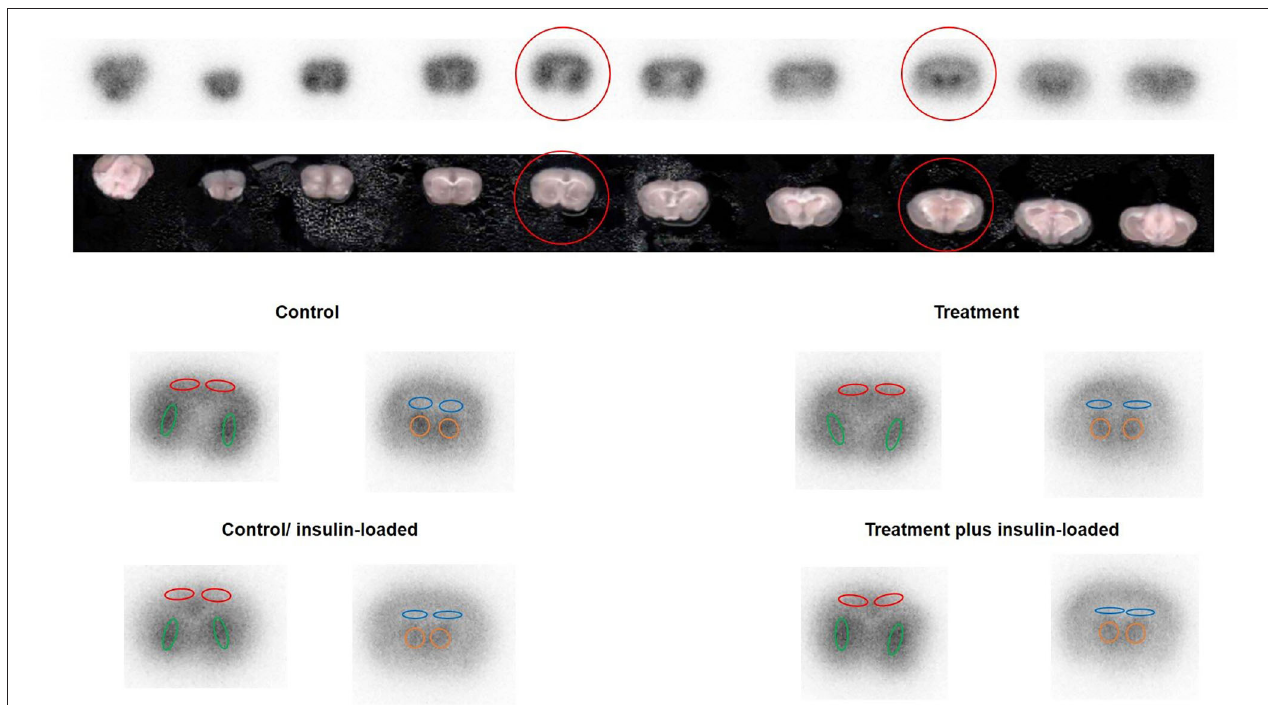
FIGURE 2 | The original picture of brain coronal slices together with the brain 18 F-FDG ARG image. ROIs were placed on an 18 F-FDG autoradiography image to cover the cortex, striatum, hippocampus, and thalamus on the left and right hemispheres in four groups. The cortex is encircled in red, the striatum in green, the hippocampus in blue, and the thalamus in orange.